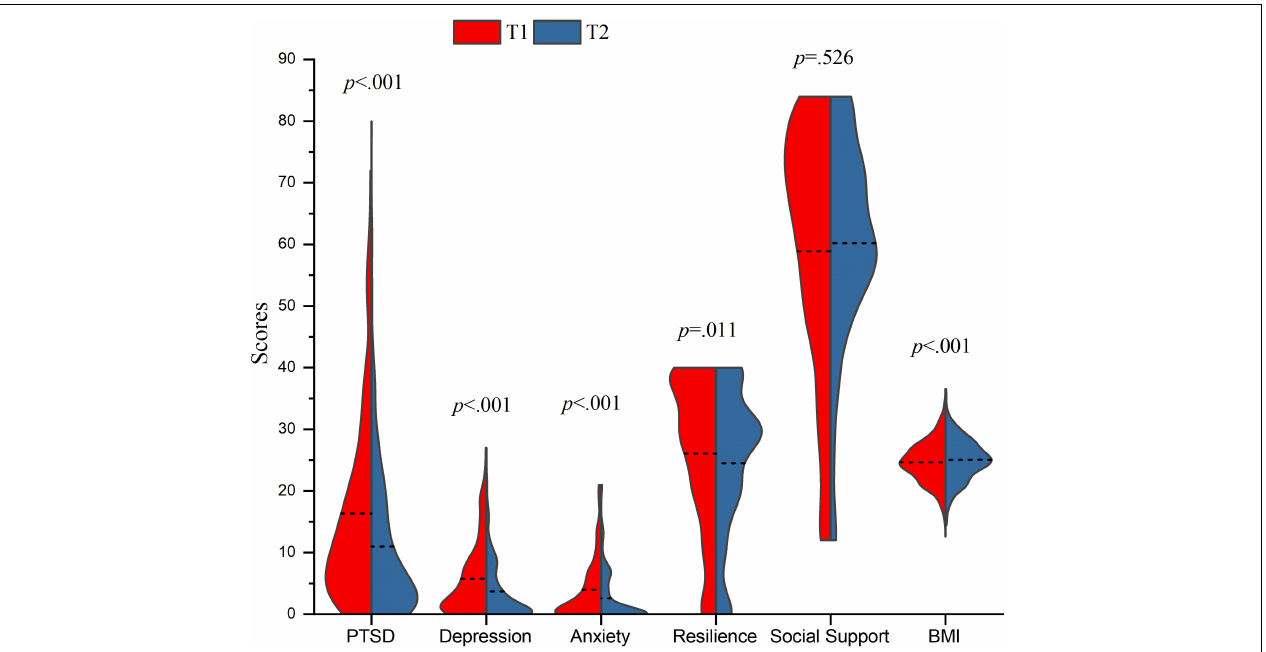
FIGURE 1 | Temporal changes of PTSD, depression, anxiety, resilience, social support, and BMI. related-samples Wilcoxon signed rank test were conducted on PTSD, depression, anxiety, resilience and social support due to the non-normality of data. The paired samples t -test was conducted on BMI based on the normality of data. The horizontal dash lines were used to indicate the mean